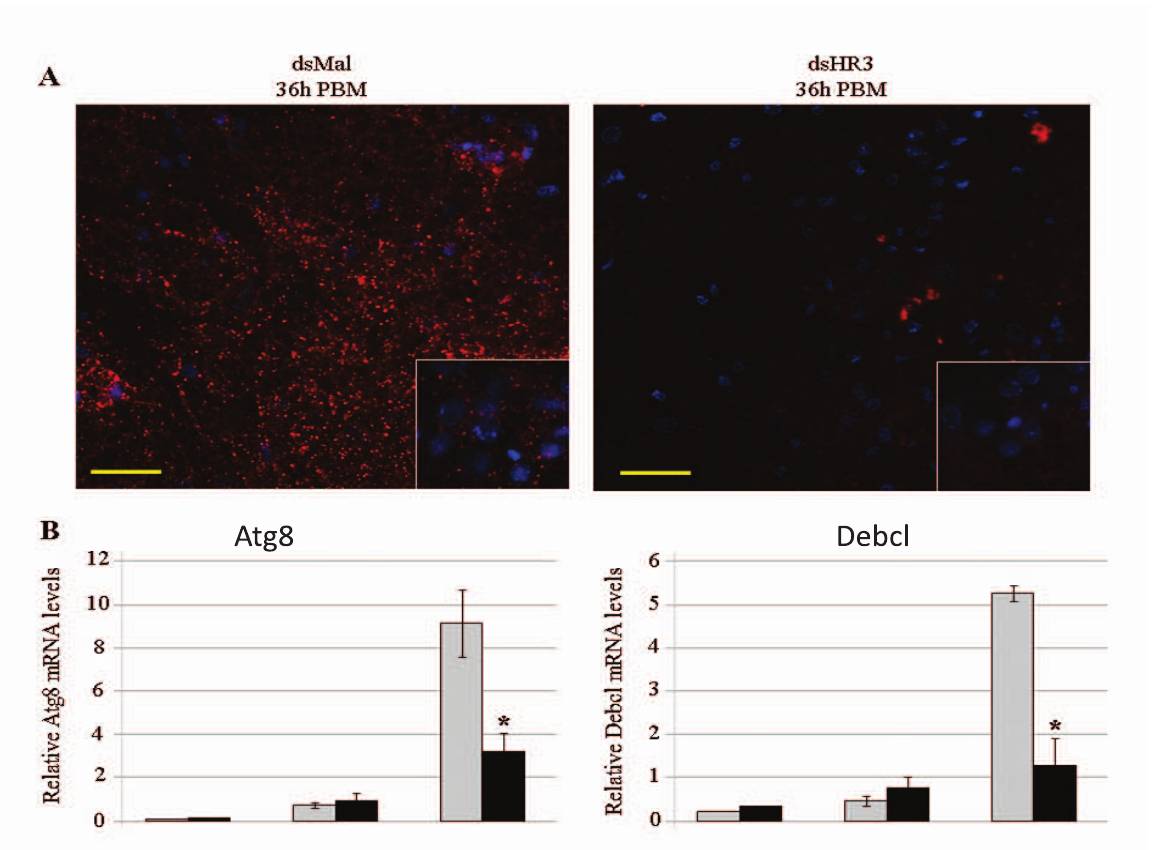
Figure 4. HR3 RNAi depletion impaired the programmed fat body autophagy at the end of the vitellogenic cycle. (A) Lysotracker and DAPI staining of adult female FBs, 36 h PBM, treated with 1 m g of dsMal or dsHR3 RNAi. Newly emerged female mosquitoes were injected, and five days later they received a blood meal. FBs were dissected 36 h PBM and incubated for 5 min in a solution containing 200 nM of LysoTracker Red DND-99 and 0.01 microg/microl of DAPI. The scale bar is 50 m m. (B) mRNA levels of two genes involved in fat body autophagy at the end of the first vitellogenic cycle in the fat body of Aedes female mosquitoes. qPCR was performed as described before using specific primers for Atg8 and Debcl genes. Each sample was normalized to its internal control ribosomal protein-7 mRNA and three independent experiments were assayed. *Indicates statistical significance , 0.05.